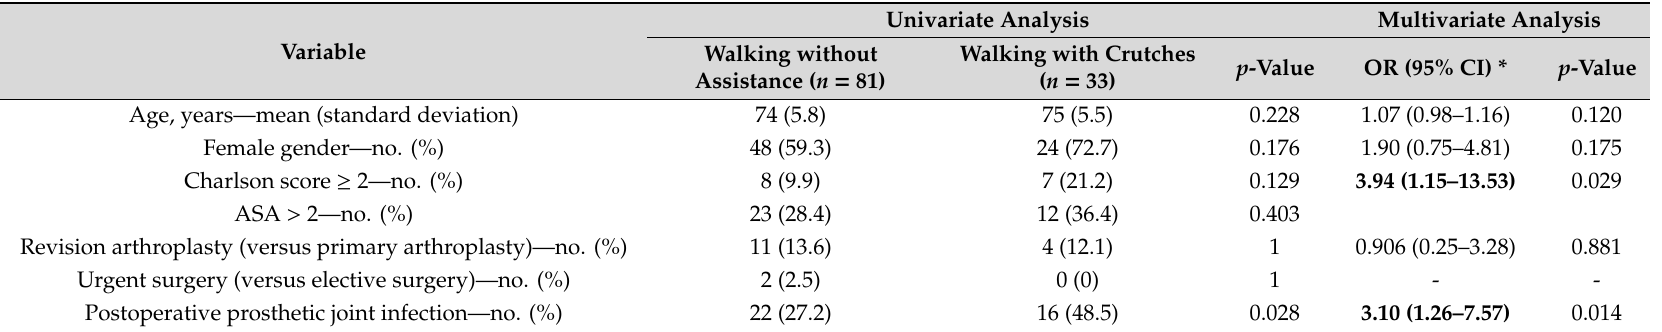
Table 3. Factors associated with requiring an assistive device for ambulation versus walking without assistance in 114 patients undergoing total knee replacements one year after the last surgical procedure.